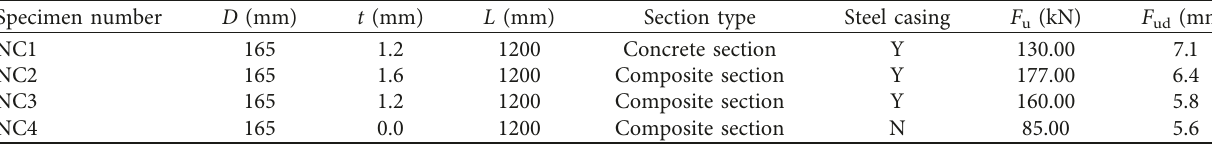
Table 4: Test results of common specimens.